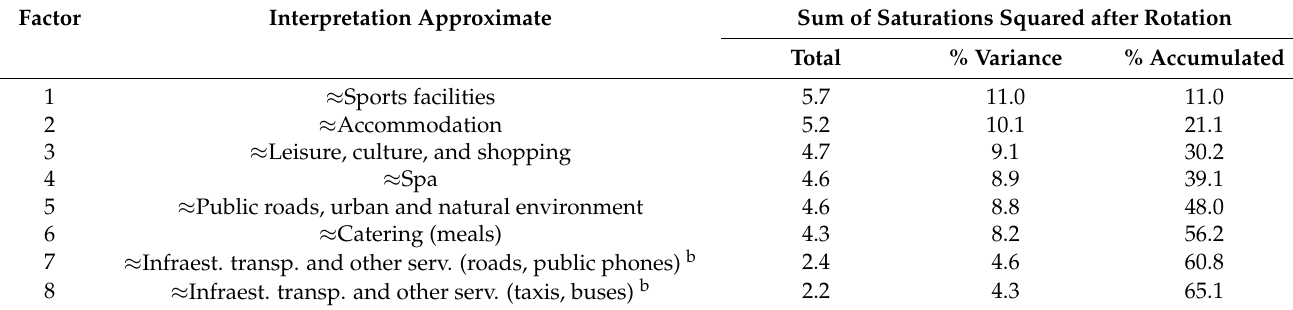
Table 8. Variance explained with rotated factors (Varimax rotation) ( n = 725) a .